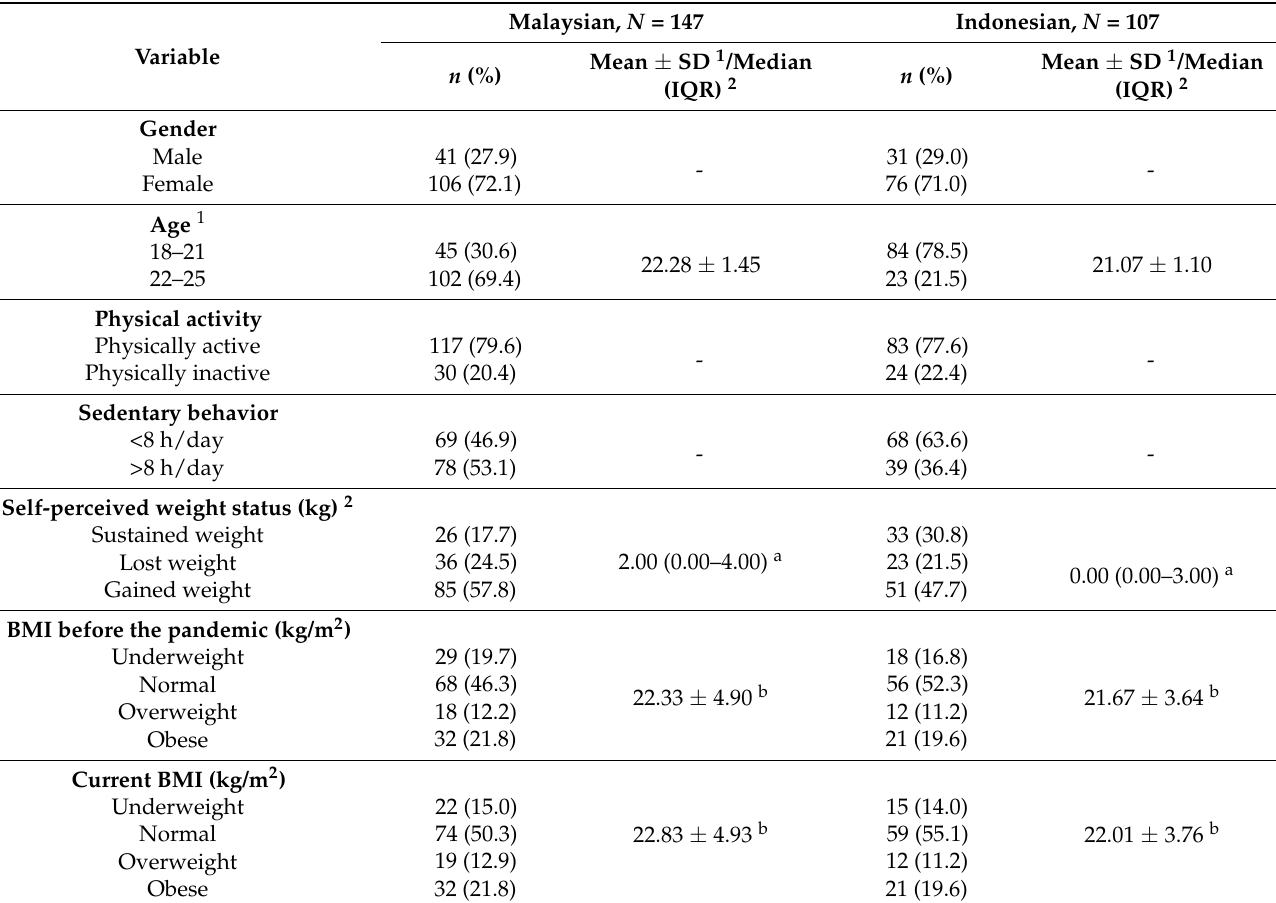
Table 1. Socio-demographic characteristics, physical activity, sedentary behavior, and self-perceived weight status of the